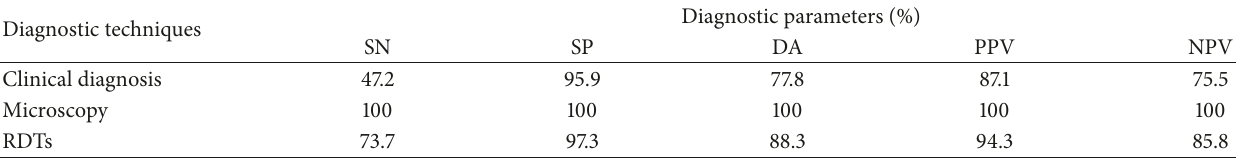
Table 2: Diagnostic efficiency of presumptive diagnosis and RDTs using microscopy as a